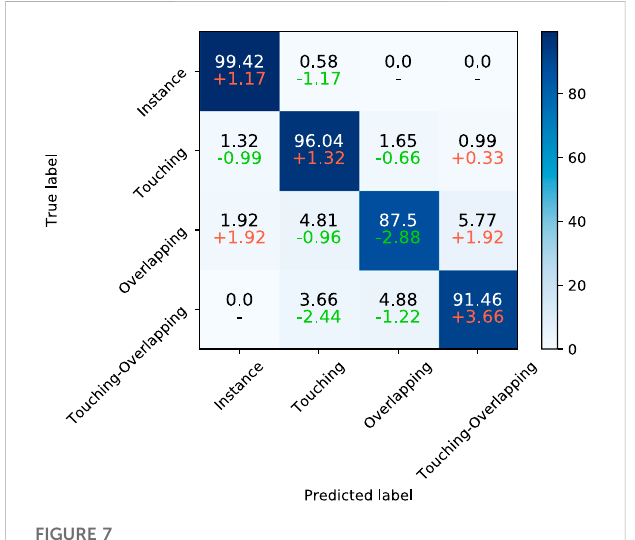
The bold values represent that they are the best performance in this metric.